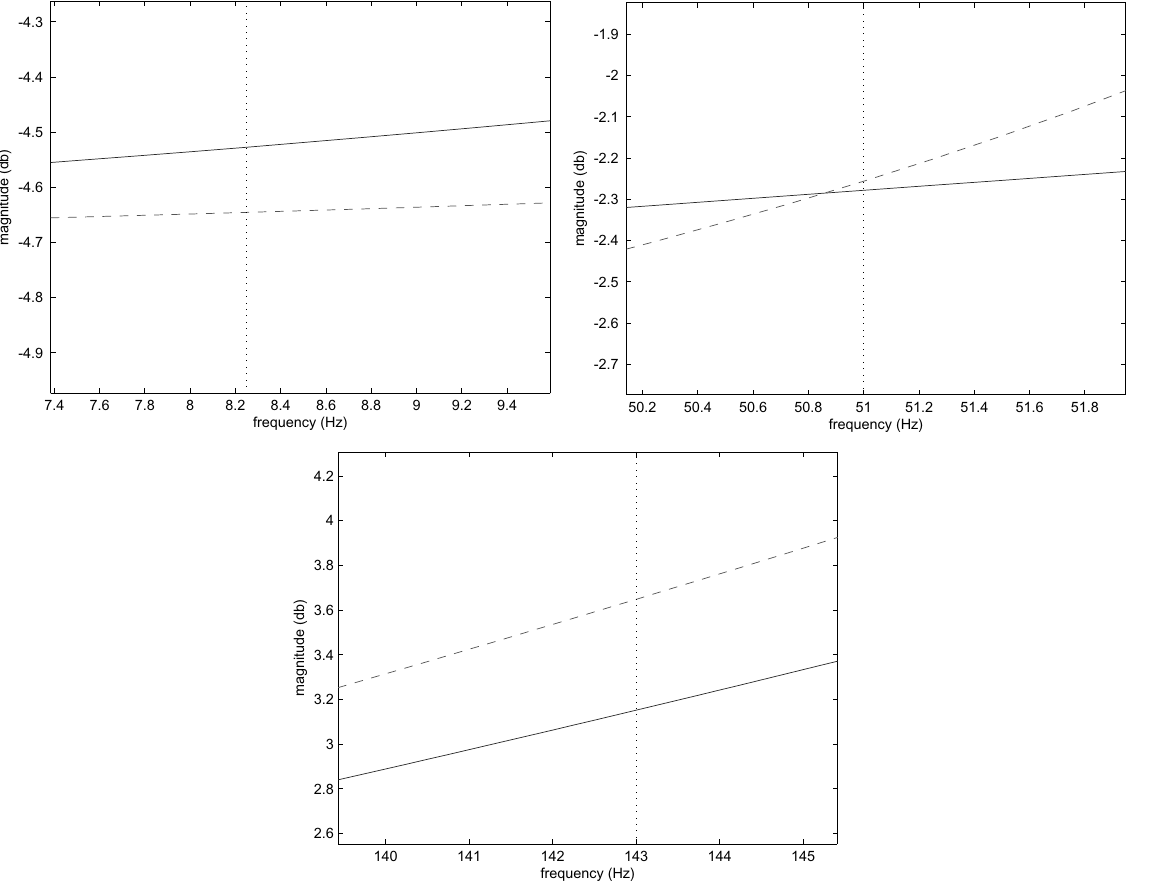
Fig. 18. Transmissibility function between point 7 and point 8 for undamaged structure for loading case 1 (full line, force applied in DOF 1) and damaged structure for loading case 2 (dashed line, force applied in DOF 3).